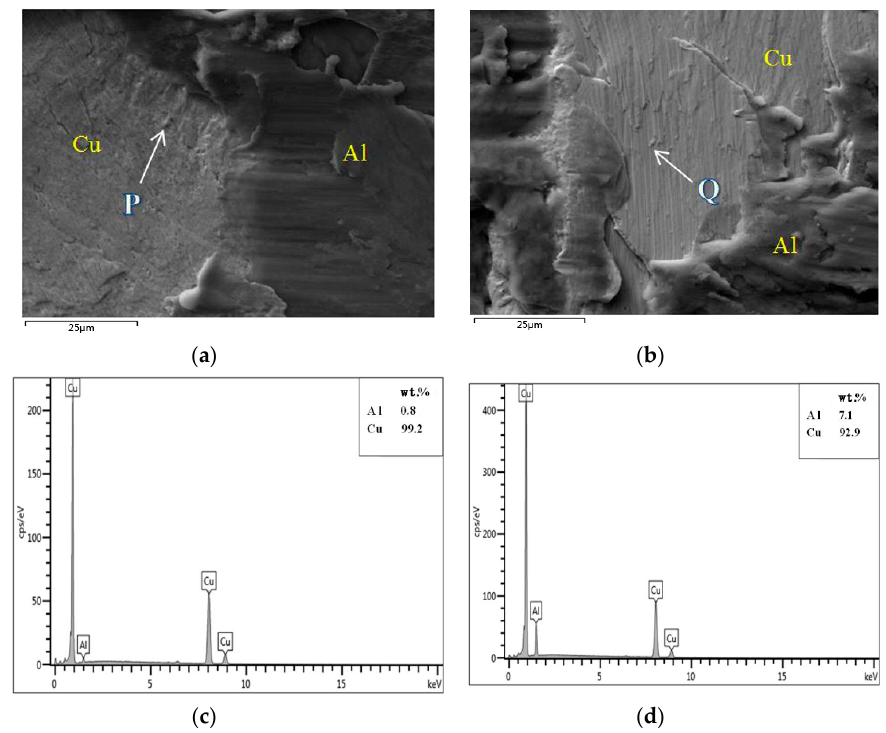
Figure 7. Image of the shear interface on the copper side. ( a ) Unpulsed copper side; ( b ) pulse copper side; ( c ) proportion of elements at point P; ( d ) proportion of elements at point Q.